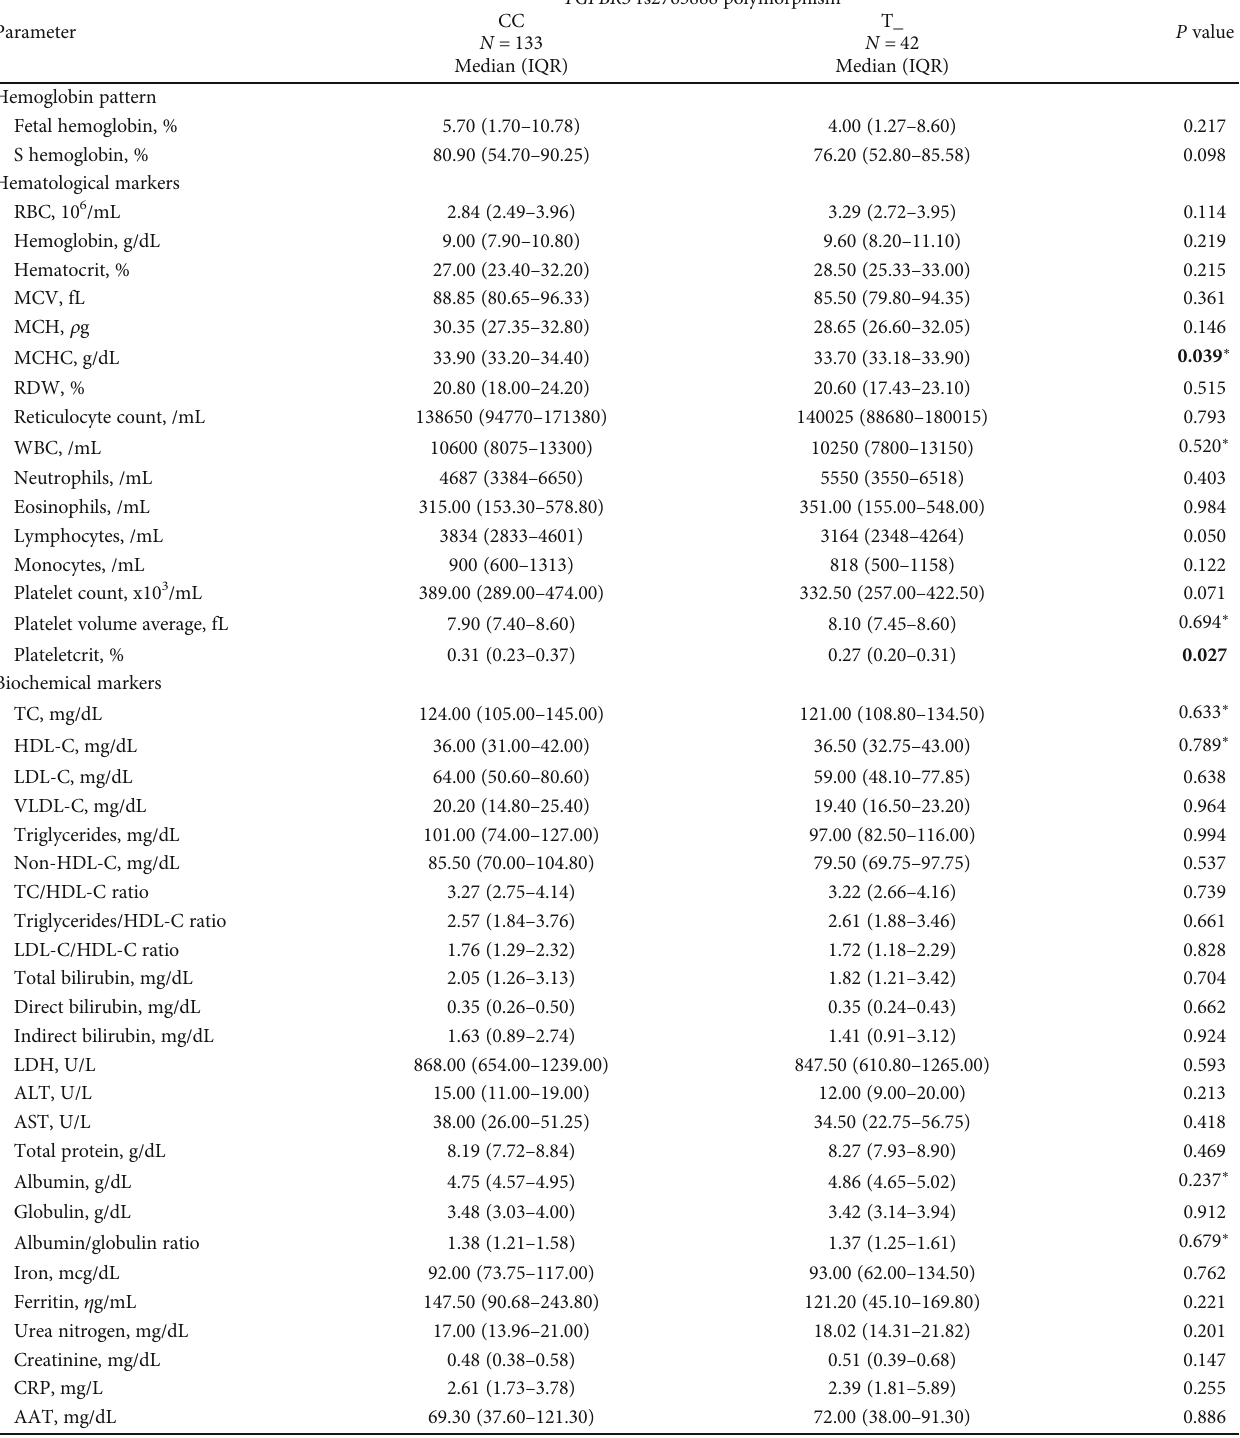
Table 2: Association of TGFBR3 rs2765888 polymorphism with laboratory biomarkers using the dominant genetic